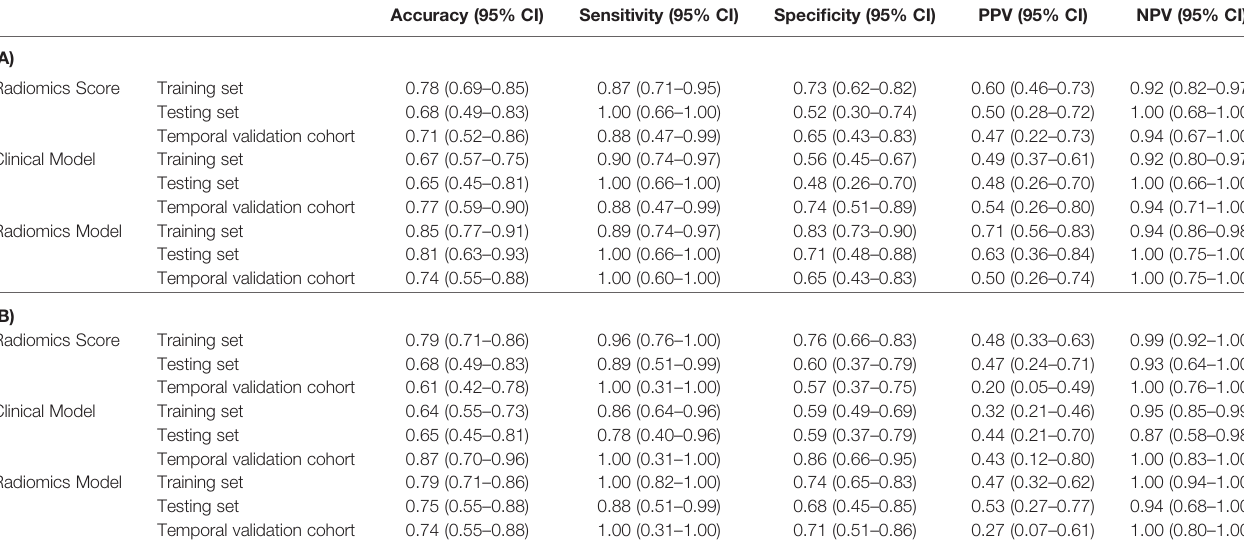
TABLE 4 | Predictive performances of different models.